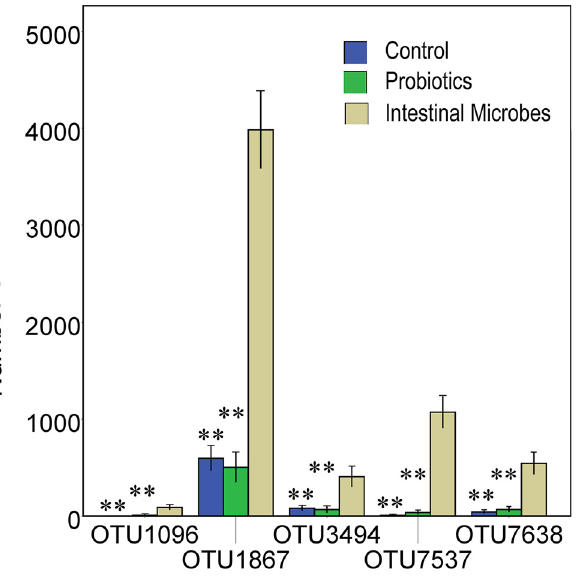
Fig 3. Comparison of OTU-levels in the gut microbiota between the control, probiotics, and intestinal microbes groups. (n = 8; * p < 0.05, ** p < 0.01, based on a two-tailed least significant difference test).